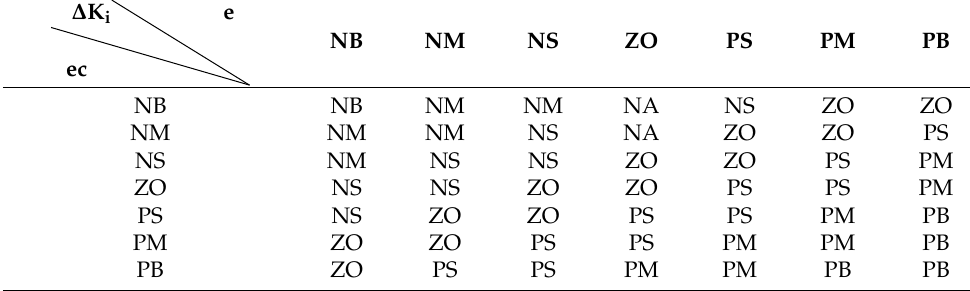
Table 4. ∆ K i Fuzzy control rule table.